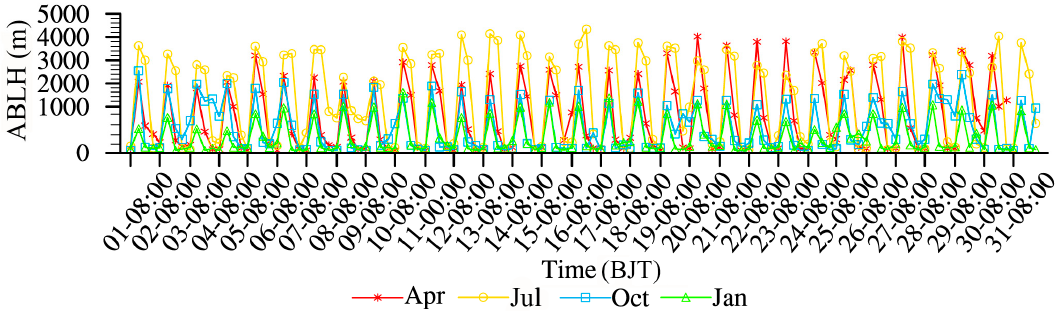
Figure 3. Hourly variation of the boundary layer height over Dunhuang in monthly averages in April, July, October, 2016 and January, 2017.